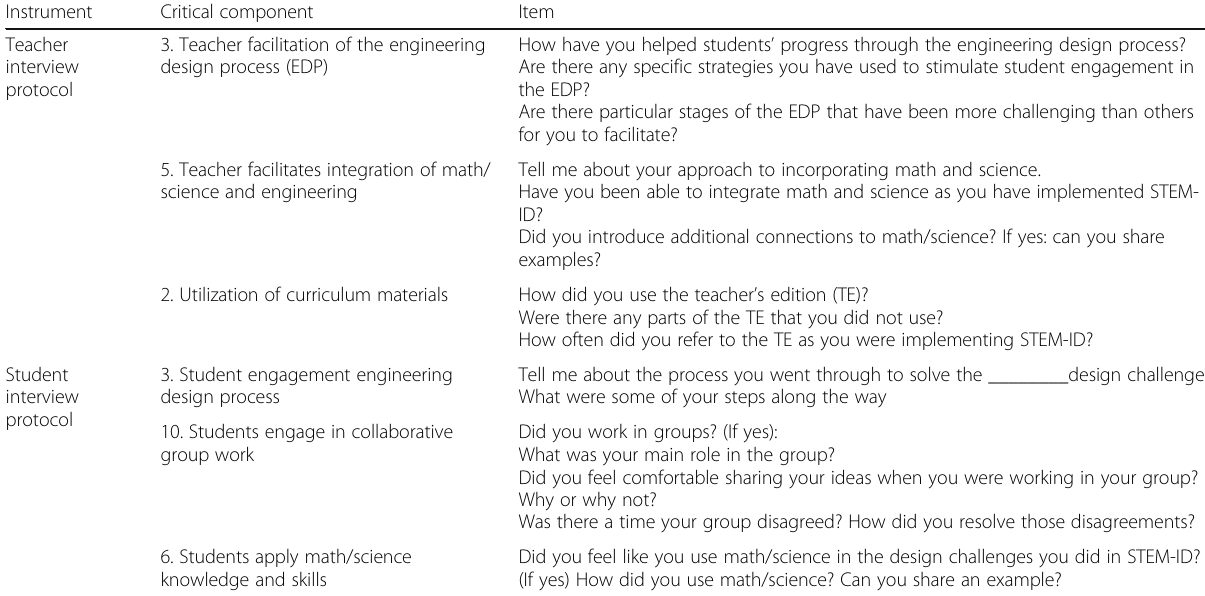
Table 4 Example items from STEM-ID interview protocols